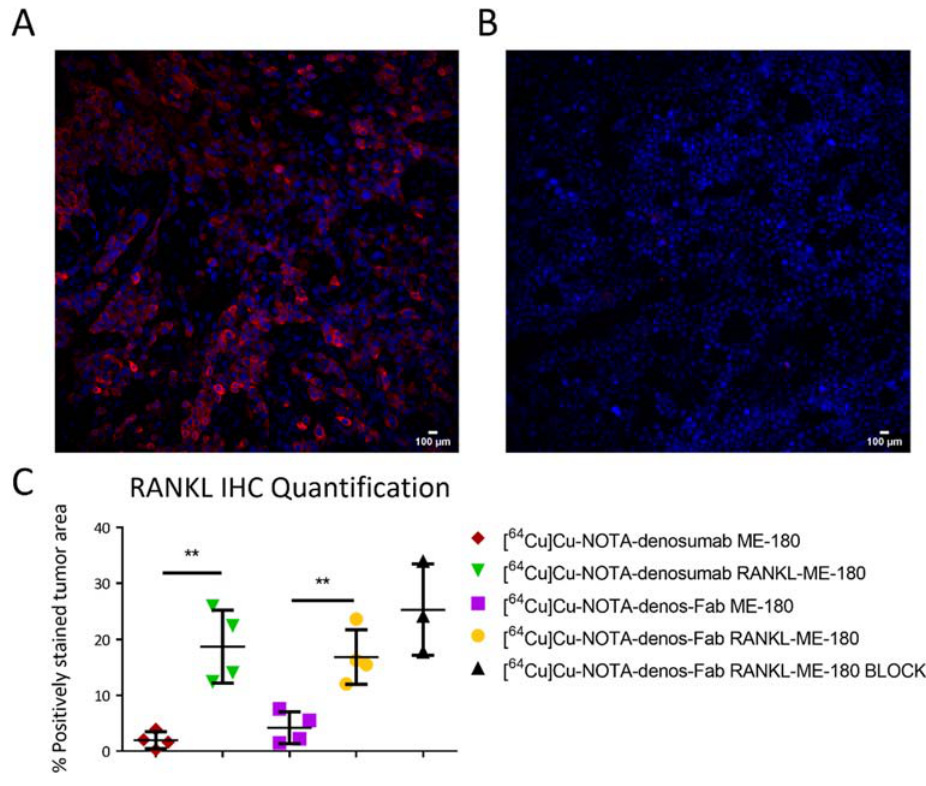
Figure 7. Histology and IHC quantification. Immunofluorescence staining of ( A ) RANKL ‐ ME ‐ 180 xenografts and ( B ) ME ‐ 180 xenografts. ( C ) RANKL IHC quantification in the different animal groups. (Images acquired using 20× objective, mean ± 1 standard deviation; ** p ≤ 0.01).